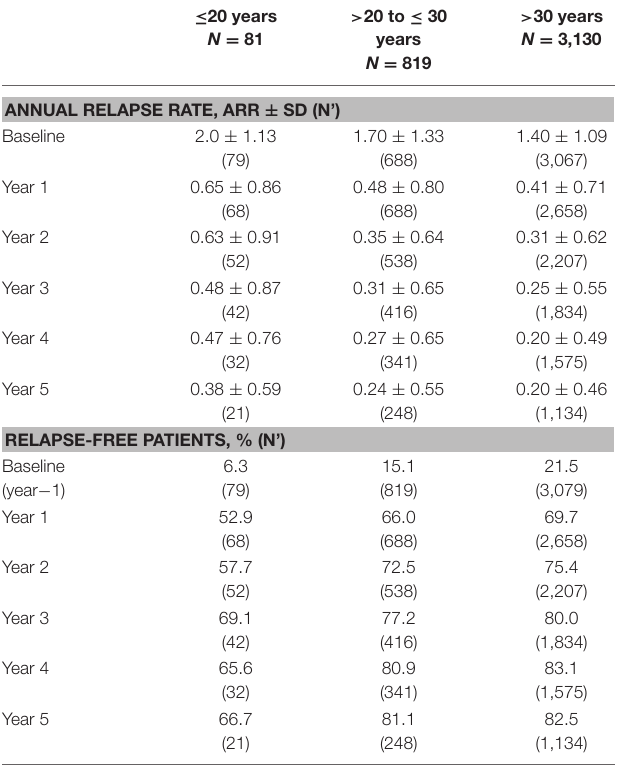
TABLE 2 | Annual relapse rate and proportion of relapse-free patients. ≤ 20 years N = 81